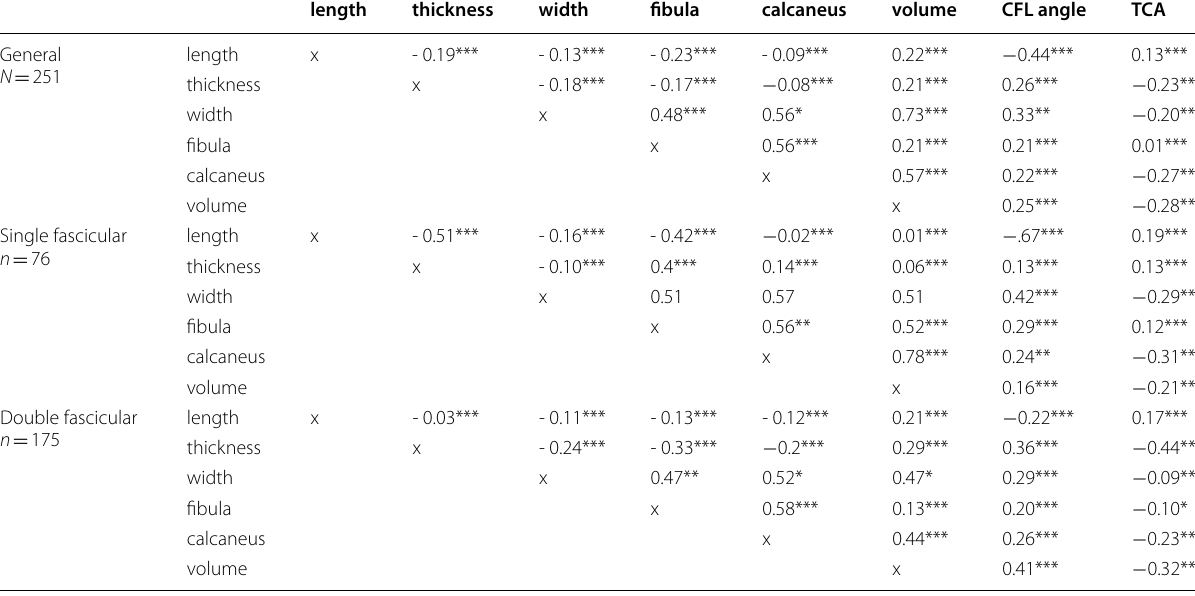
Table 5 Correlations of the calcaneofibular ligament’s